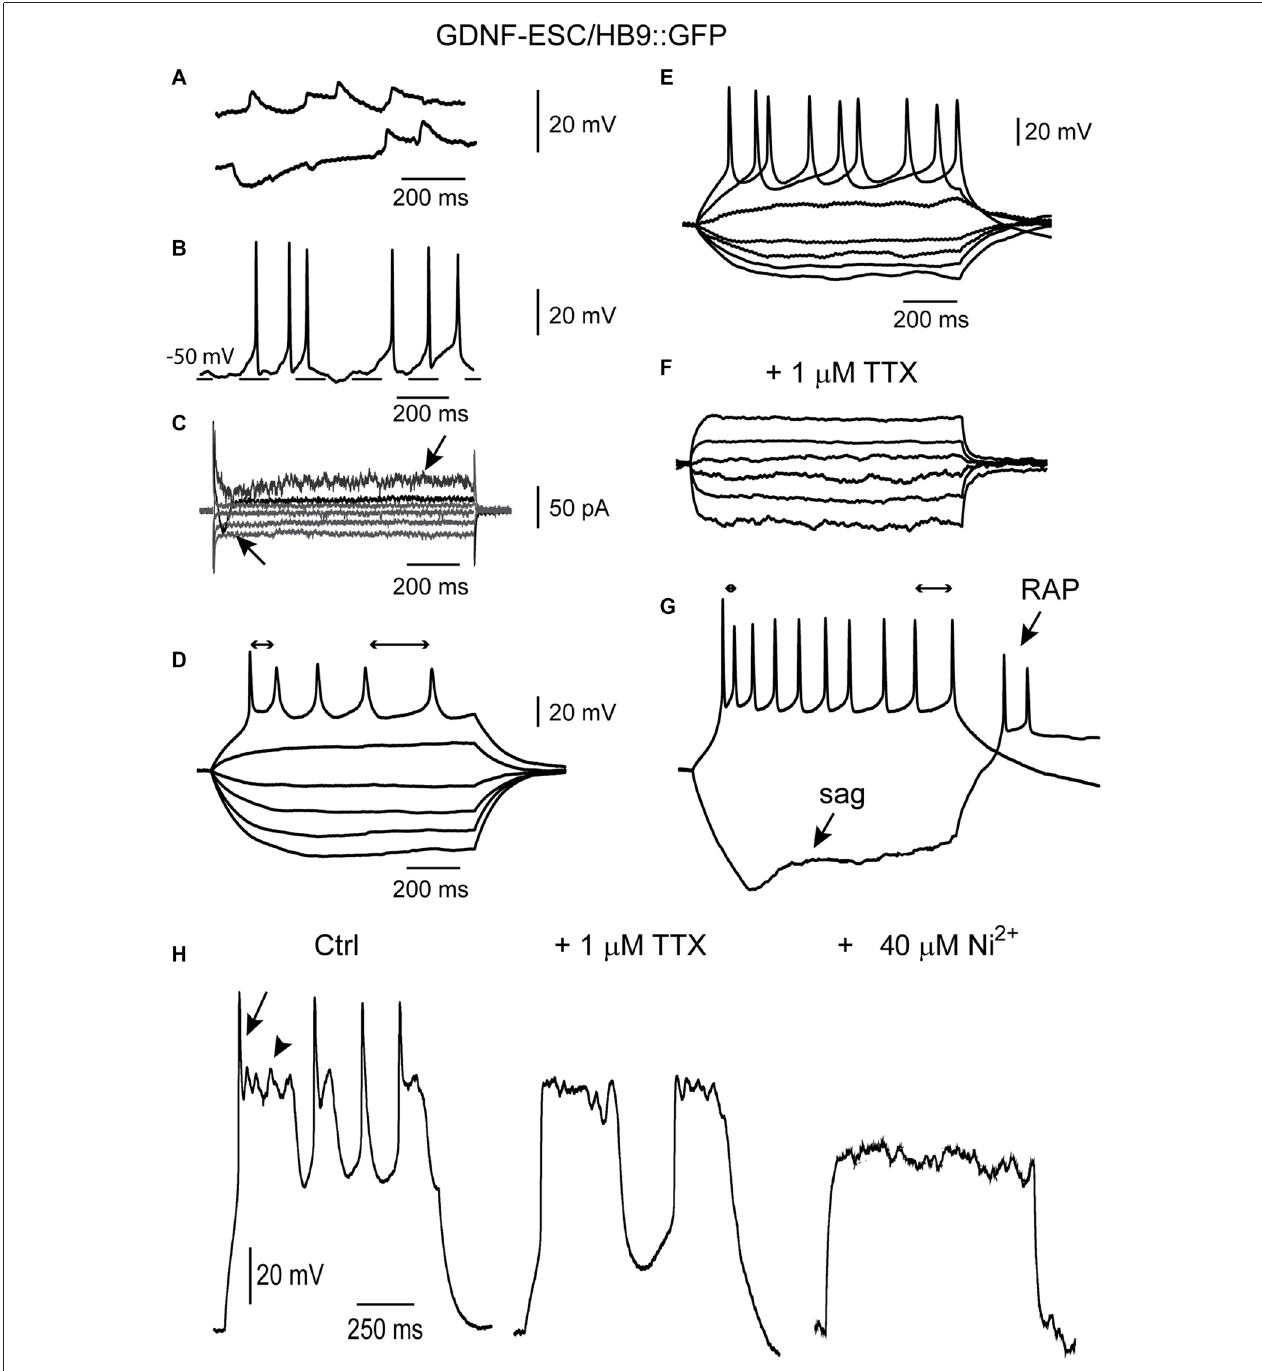
FIGURE 7 | Some maturation signs are present only in cultured GDNF-ESC/HB9::GFP MNs. (A) Putative depolarizing and hyperpolarizing synaptic events. (B) At certain membrane potentials, putative synaptic events provoke the firing of APs. (C) Point somatic voltage clamp frequently showed inward currents (arrow pointing to top). Signs of developing delayed rectification were also observed (arrow pointing to bottom). Voltage commands are not illustrated. (D) Repetitive APs as well as frequency adaptation (bidirectional arrows show different interspike intervals at the beginning and end of the evoked spike train). (E,F) Repetitive APs (E) are blocked (F) by 1 µ M tetrodotoxin (TTX). (G) A more mature MN showing brief repetitive APs exhibiting frequency adaptation (bidirectional arrows), the sag of inward rectification (bottom arrow) and RAPs (top arrow) at the end of the hyperpolarization. (H) Control (left) recording showing mixed regenerative and repetitive propagating events in one neuron evoked with intracellular current steps (not shown). Arrow, a putative Na + current; arrowhead: a Ca 2 + plateau. After adding 1 µ M TTX, Na + spikes were gone, leaving the Ca 2 + potentials (middle). Finally, after adding 40 µ M Ni 2 + to the same cell in the continuous presence of TTX, Ca 2 + potentials were also blocked